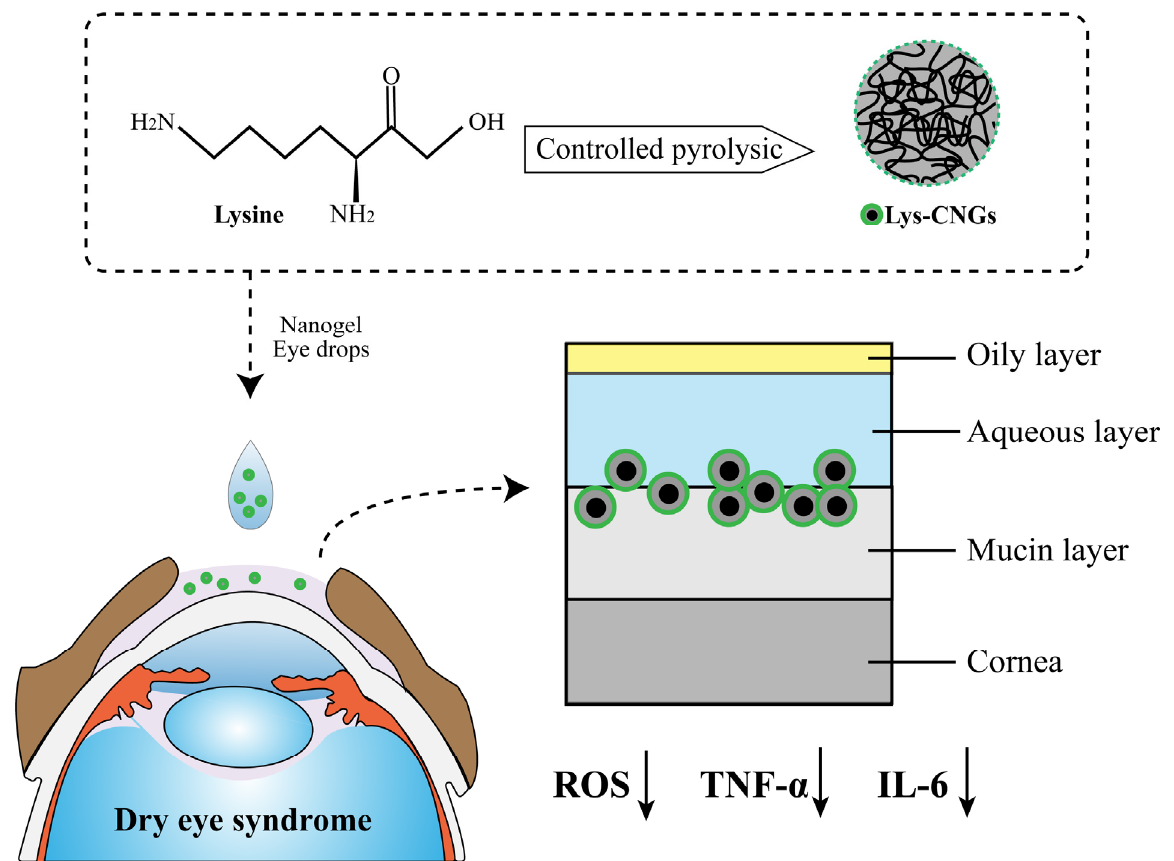
Figure 5. Lysine-carbonized nanogels (Lys-CNGs) were prepared as eye drops to treat dry eye syndrome (DES) through controlled pyrolysis of lysine. Lys-CNGs inhibit the overexpression of ROS and proinflammatory cytokines TNF- α & IL-6, which have significant effects on the development of DES. In addition, Lys-CNGs penetrate into the mucin layer to prolong retention time at the ocular surface.